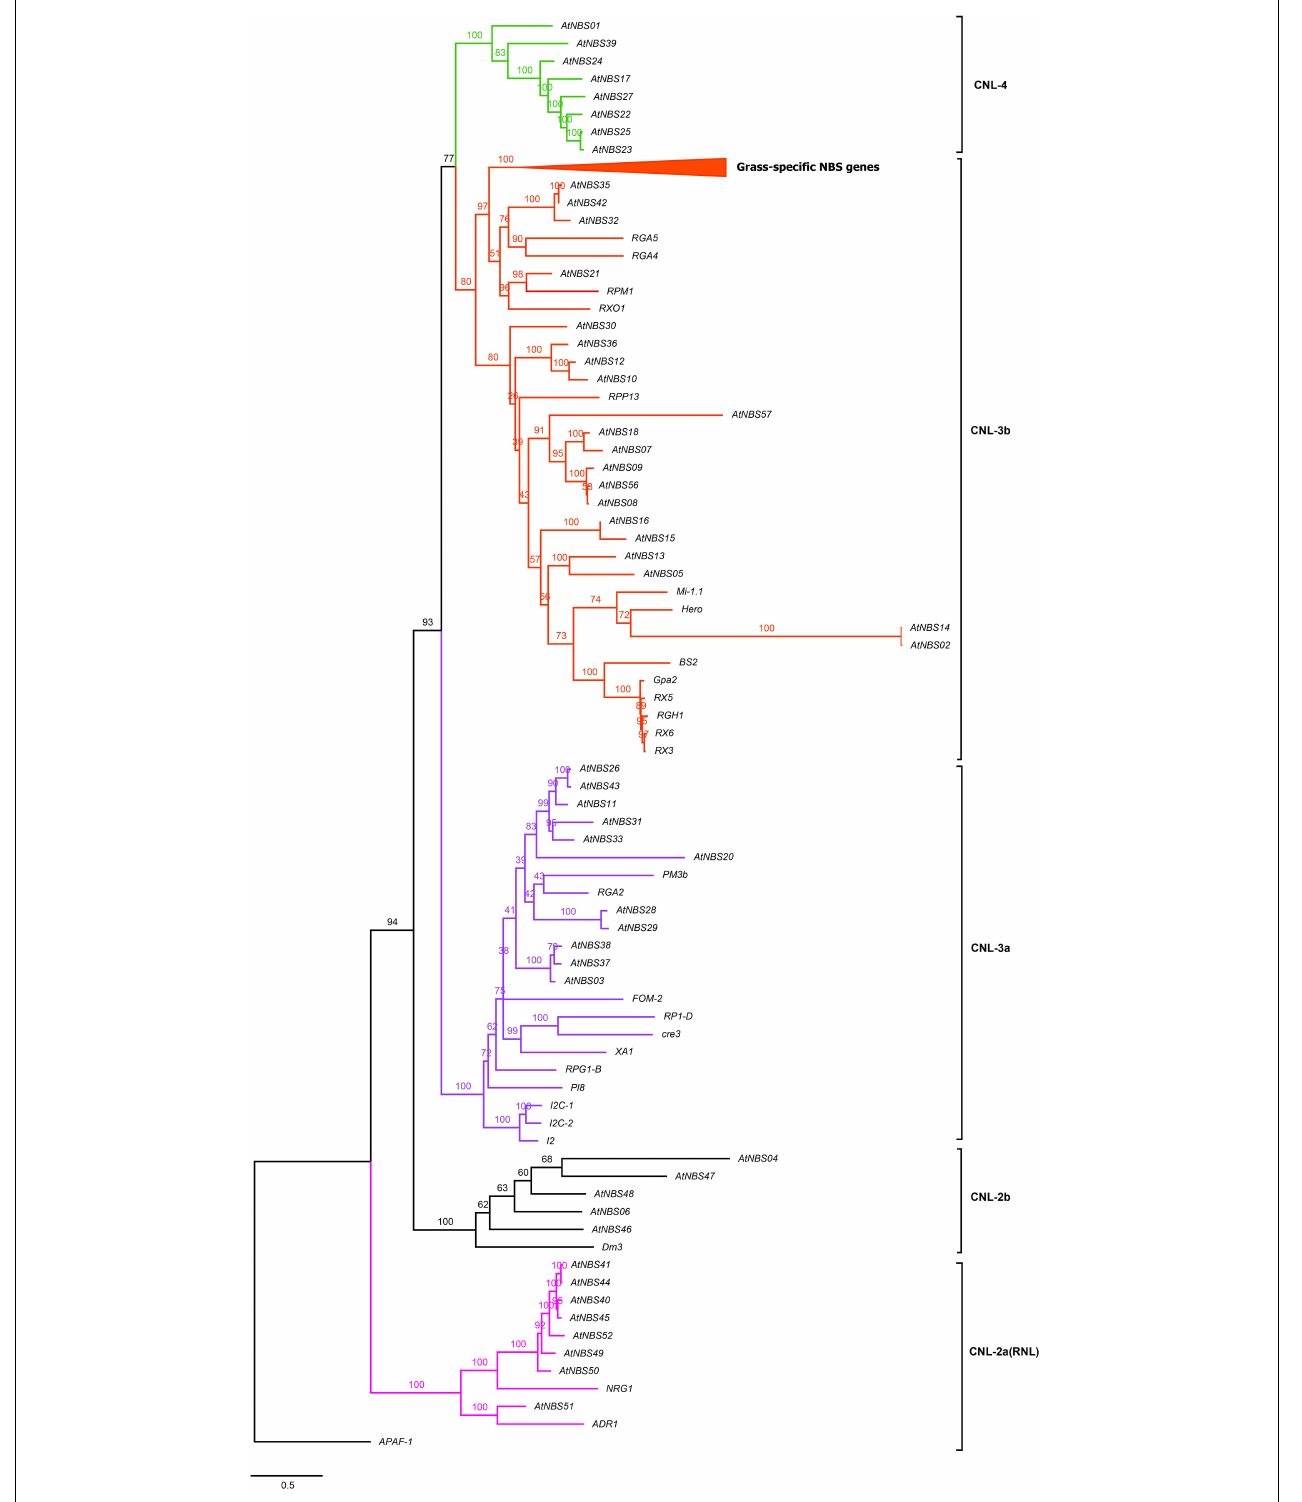
FIGURE 5 | Reconstructed tree of the CNL subclass of A. trifoliata NBS proteins. Pink, black, purple, red and green represent the CNL-2a (RNL), CNL-2b, CNL-3a, CNL-3b, and CNL-4 clades, respectively. The top clade in the CNL-3b clade is compressed, and the complete tree is shown in Supplementary Figure 1 because it clusters R genes that are specific to grasses and do not group together with any A. trifoliata NBS candidates. Members of this clade include Pi-ta and Pik-1/2 from O. sativa L. and Mla1 , MLA12 and RPG5 from Hordeum vulgare L.